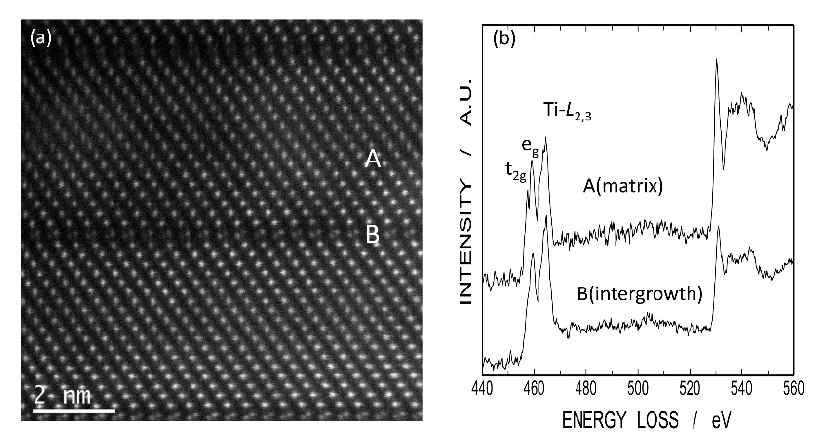
Figure 11. High-angle annular dark field scanning TEM (HAADF-STEM) image of LNT with Ti 20 mol % in ( a ) and electron energy-loss spectroscope (EELS) data for L 2,3 -edge of Ti ion at intergrowth layer and matrix in ( b ).